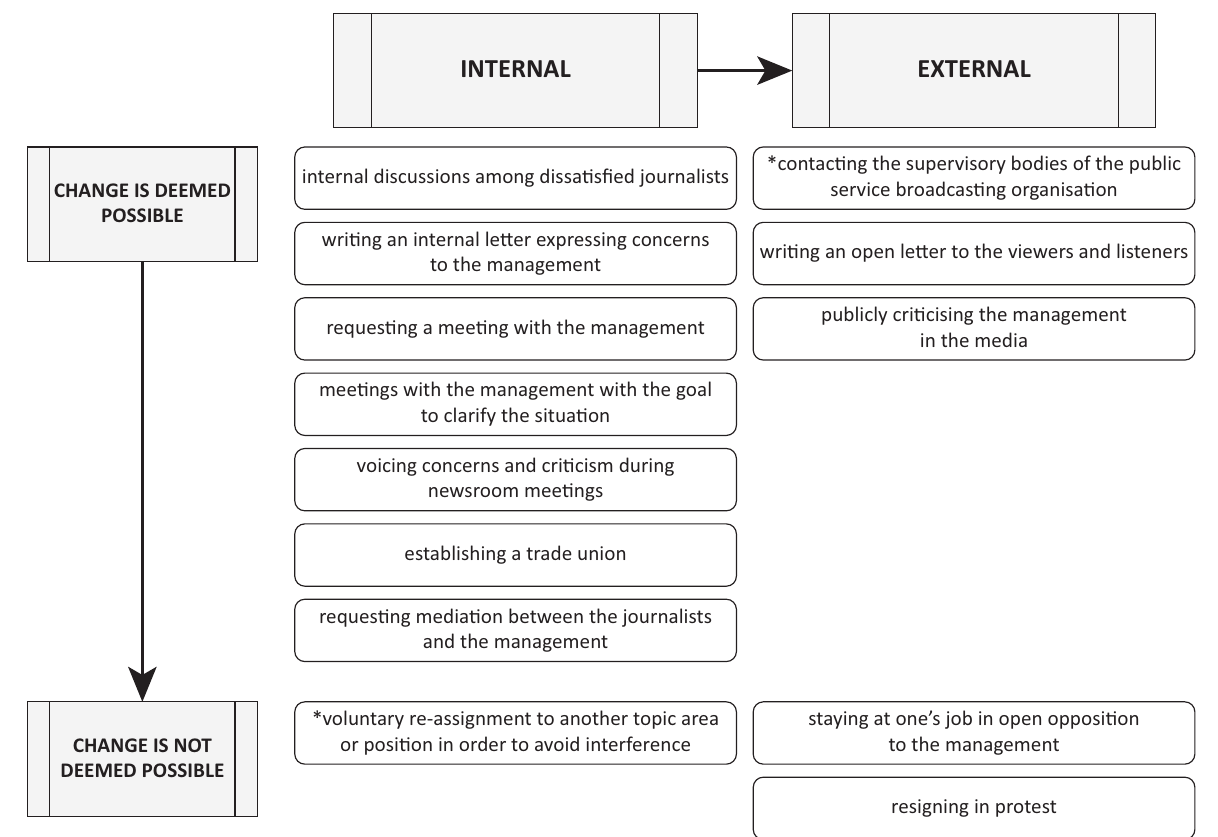
Figure 1. Resistance practices of the journalists facing internal interference with their professional autonomy. Note: The practices marked with an asterisk were mentioned by the research participants as a considered option, but they were not actually